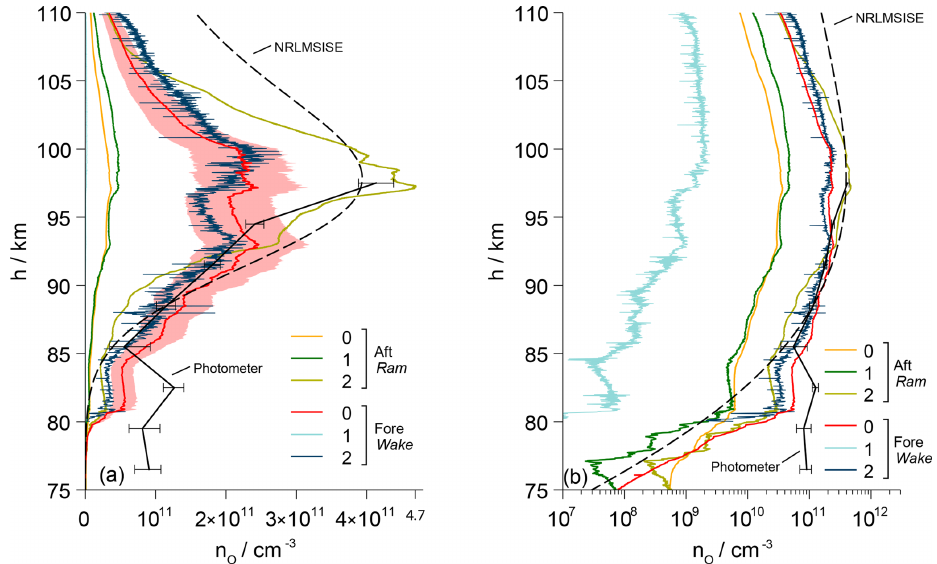
Figure 12. (a) Vertical profile of the atomic oxygen number density along the downleg of WADIS-2 including aerodynamic corrections. Aft sensors are in ram, fore sensors in wake. The low values of Fore-1 are not resolved here. The shading around the profile of sensor Fore-0 indicates the uncertainty of the calibration. The profiles derived from the onboard airglow photometer data and the NRLMSISE-00 atmospheric model are sketched for comparison. (b) Semilogarithmic